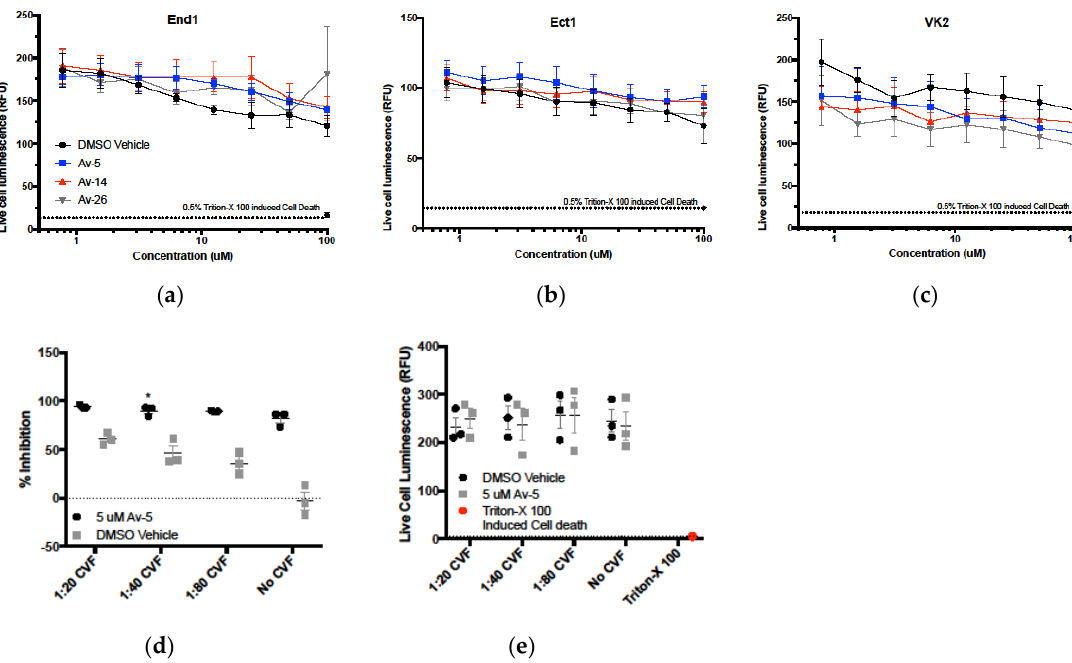
Figure 5. Cytotoxicity and antiviral activity of Avirulins in female reproductive tract epithelium. ( a – c ). Immortalized epithelial cell lines derived from the vaginal wall, ectocervix, and endocervix (VK2,